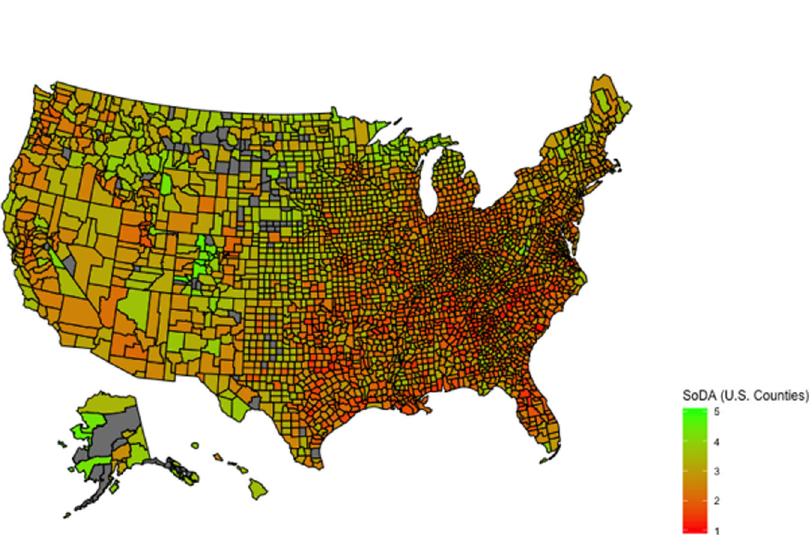
Fig. 2 Base model results heat map by United States county. States that are grey did not have suf fi cient amount of cellphone data to be included. Authors ’ analysis of authors ’ model based on data from the Unacast Social Distancing Dataset between from March 16, 2020 ( fi rst day of the national stray at home order) to April 24, 2020 ( fi rst day a state relaxed the social distancing guidelines), CDC, MIT Election Data and Science Lab, CNN news reports, and